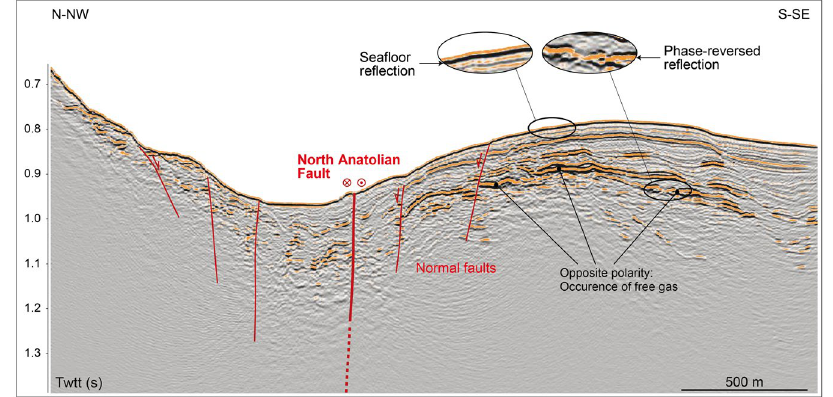
Figure 6. Seismic section extracted from the high-resolution 3D seismic box shot in 2009 46 along the thick black line displayed in Fig. 5, with a simplified, tentative interpretation. Image created with Arc-GIS, version